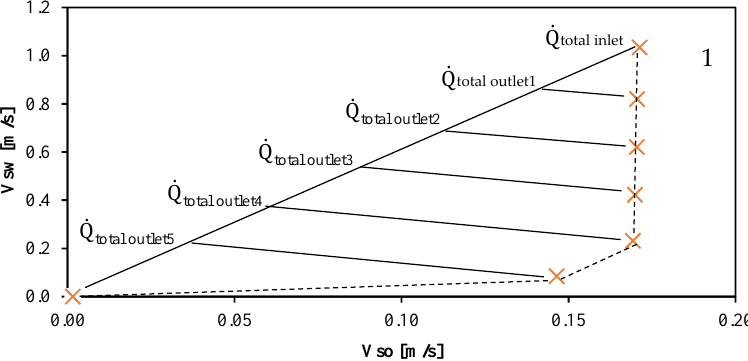
Figure 22. Drainage potential curve for total flow rate 580 L/min and WC inlet 85%. [5].